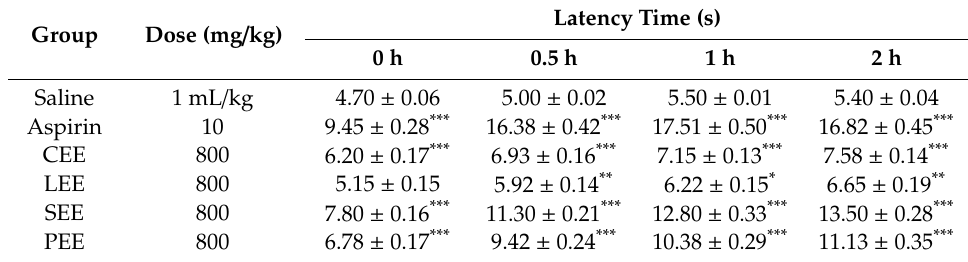
Table 1. Latency time of C. sativus ethanolic extracts in hot plate assay.